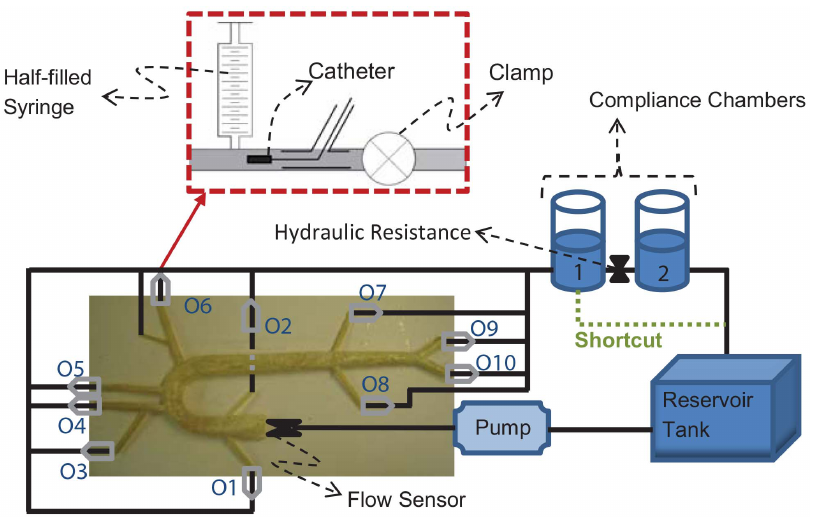
Figure 1. Schematic of the Aortic Simulator. Schematics of the outlet units are shown in the dashed-red box. The numbers at the outlets correspond to the value given in Table 3.